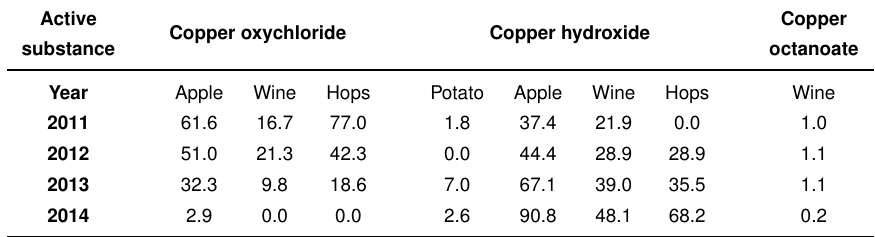
Table 4. Size of the area treated with copper-containing active substances in conventional farming [% cultivated land]